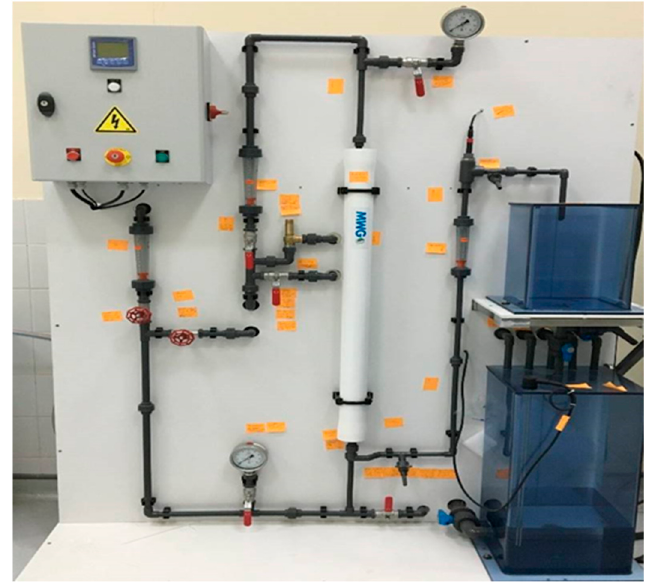
Figure 1. Simplified membrane experimental setup. Table 2. Information about Filtration Techniques.